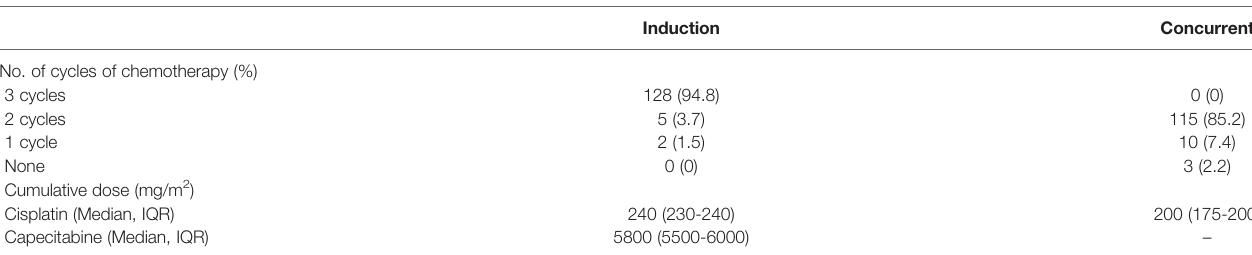
TABLE 2 | Compliance/tolerance of chemotherapy.